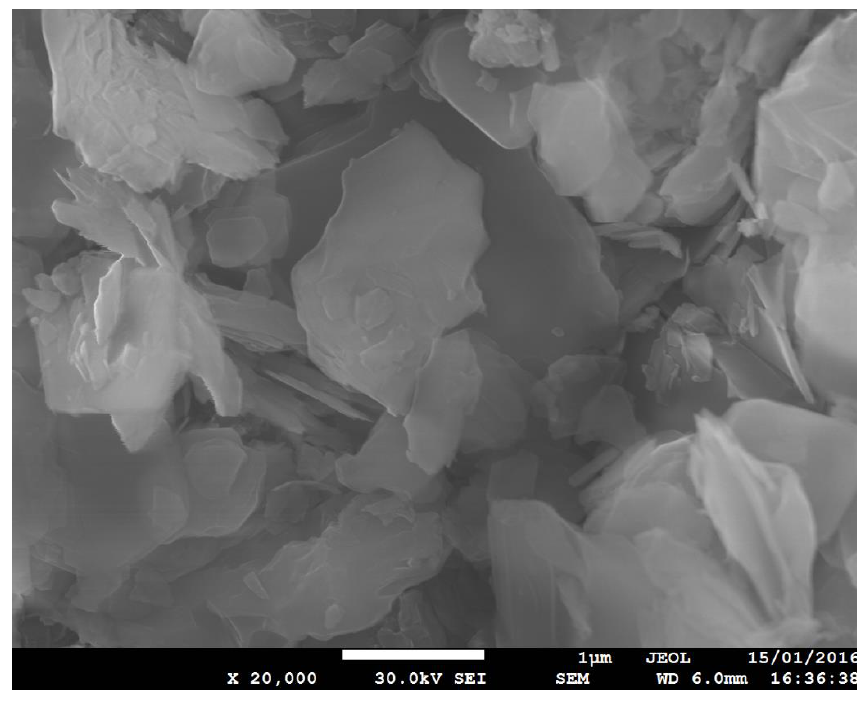
Figure 8. SEM image of tested siltstone sample with varisized particles.